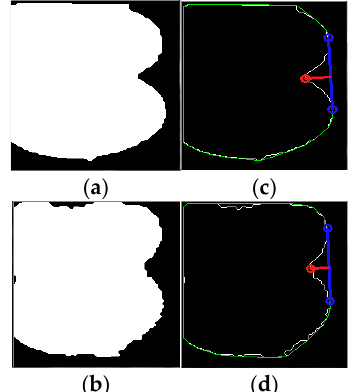
Figure 10. Insulators without ice ( a , b ) and their convexity hulls and defects of adjacent sheds ( c , d ), and insulators with ice ( e , f ) and their convexity hulls and defects of adjacent sheds ( g , h ) in Group 2.